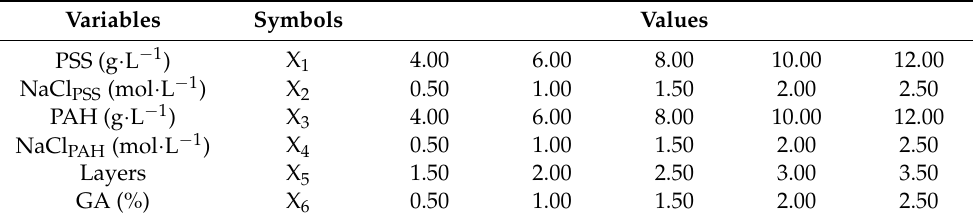
Table 1. Independent variable values for single-factor